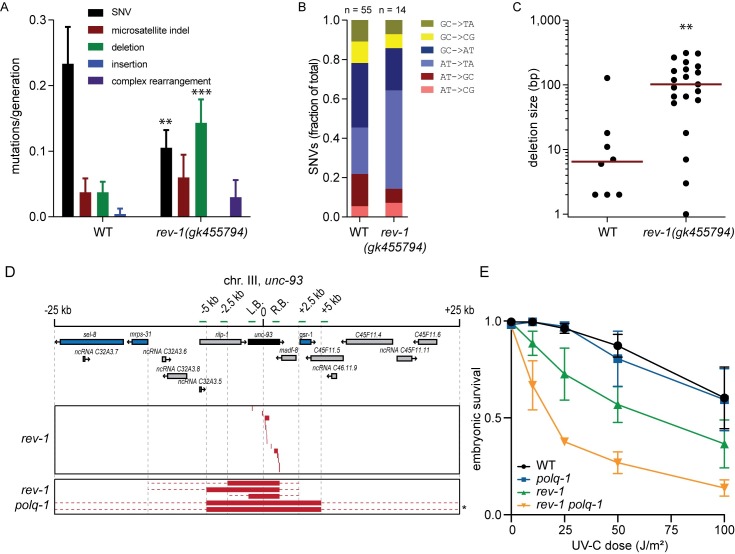
REV-1 suppresses genomic scars caused by TMEJ, without compensation by other Y-family TLS polymerases.A) WGS analysis of wild-type (WT) and rev-1 deficient animals that were grown for 40–60 generations under unperturbed conditions. Per genotype at least three independent populations were analyzed. Mutations were categorized into five different classes (** indicates p<0.01, *** indicates p<0.001, t-test). B) distribution of SNV types. C) Deletions found in WGS data plotted by size (log10 scale) for both wild-type and rev-1 deficient animals (** indicates p<0.01, Mann-Whitney). D) A schematic representation of the genome surrounding the unc-93 locus on chromosome III. Essential genes are colored blue, the unc-93 gene is colored black, while other genes are in grey. PCR amplicons used to estimate deletions sizes are indicated in green. Underneath, boxed in red a visual representation of unc-93 loss of function alleles derived from the indicated genotype. All unc-93 alleles obtained from rev-1 animals were determined at nucleotide resolution via Sanger sequencing. For the sizable unc-93 alleles that accumulated in rev-1 polq-1 the minimal (red box) and maximal (red dotted line) borders were established. * denotes animals that did not produce viable progeny, likely due to a homozygous mutation in the essential gene gsr-1. E) Progeny survival in response to UV-C exposure to hermaphrodites of the indicated genotype. Error bars denote SEM.